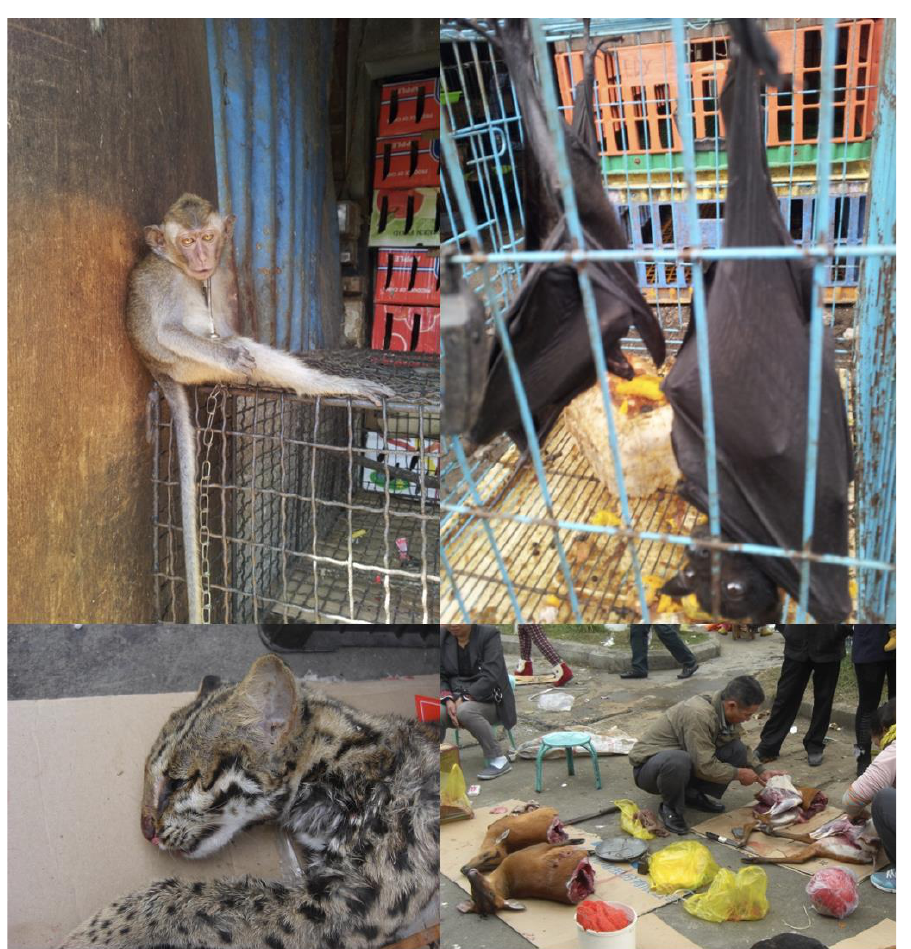
Figure 1. Wildlife observed in trade in Indonesia ( top ) and Myanmar ( bottom ), clockwise from top left: long-tailed macaque ( Macaca fascicularis ); large flying fox ( Pteropus vampyrus ); northern red muntjac ( Muntiacus vaginalis ); leopard cat ( Prionailurus bengalensis ).